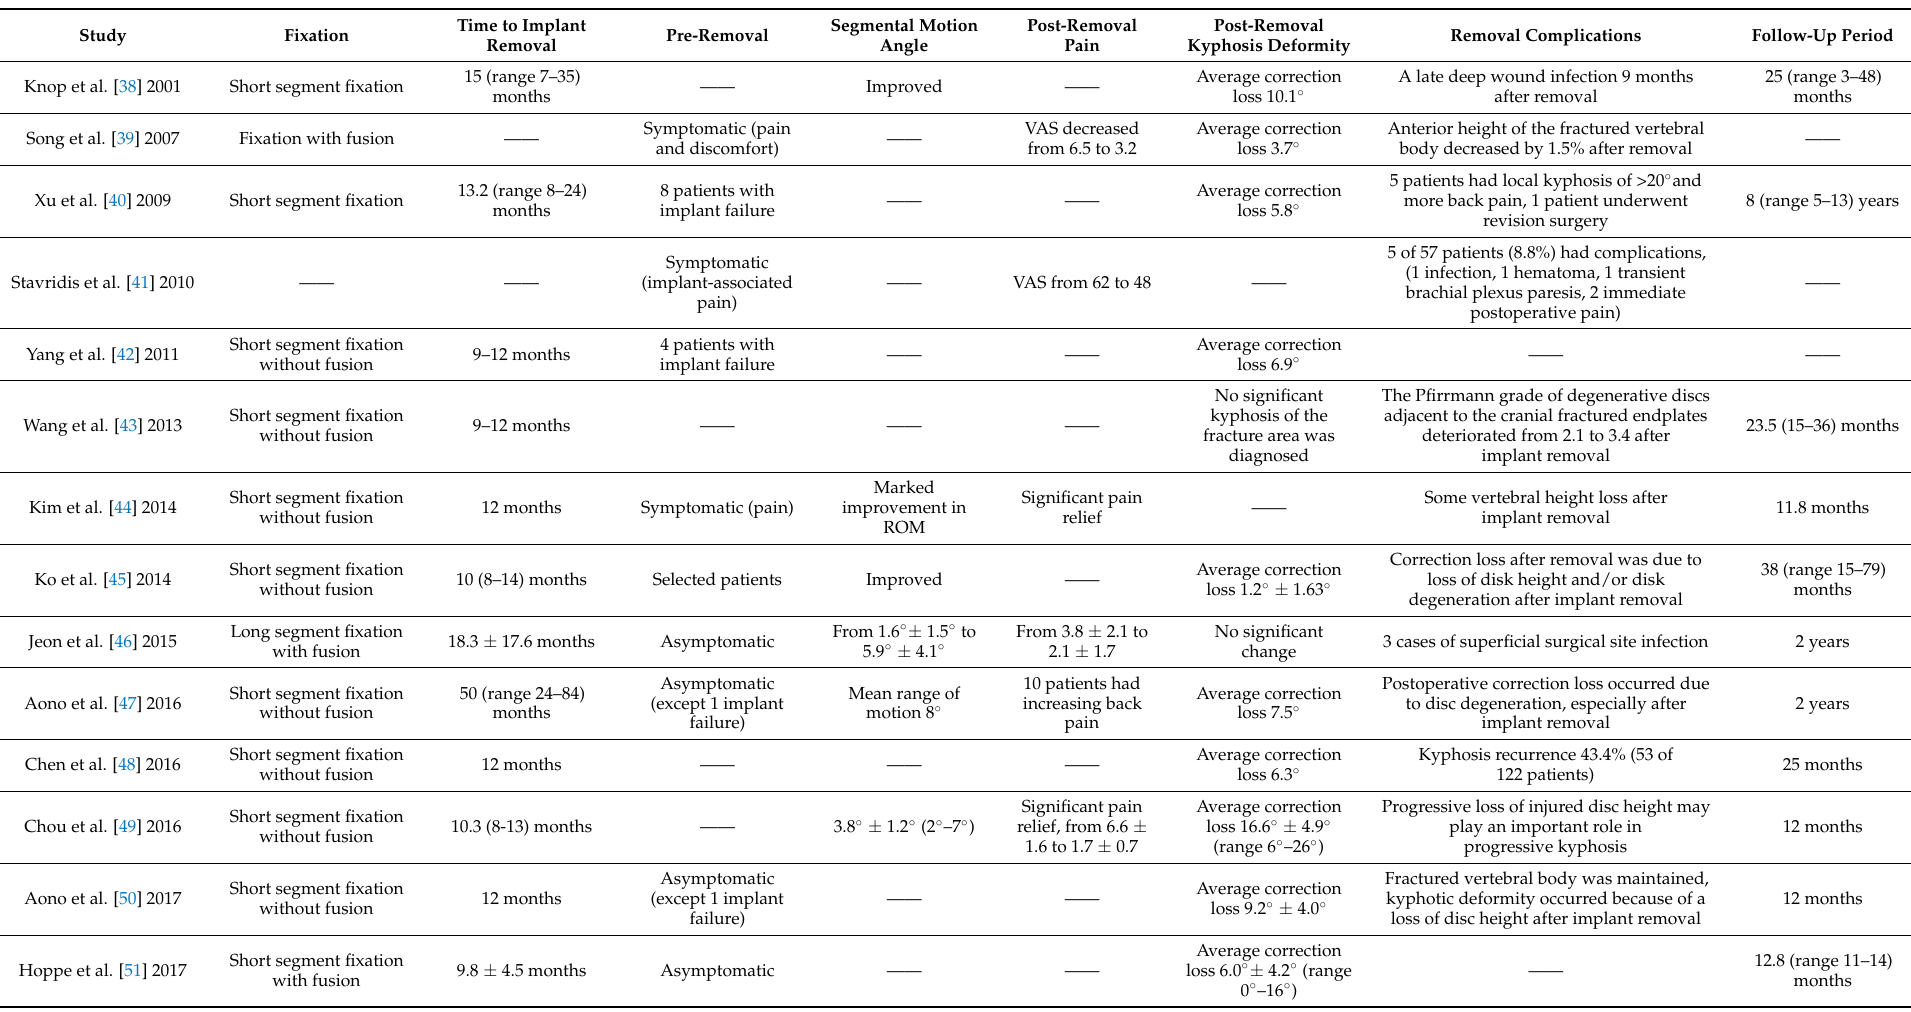
Table 2. Reported clinical outcomes in the observational